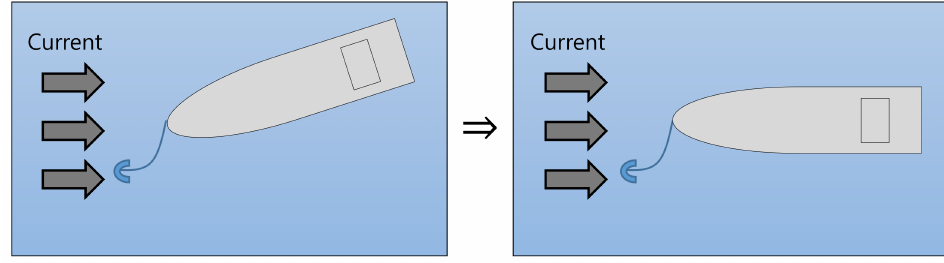
Figure 6. Heading direction of ship moored with